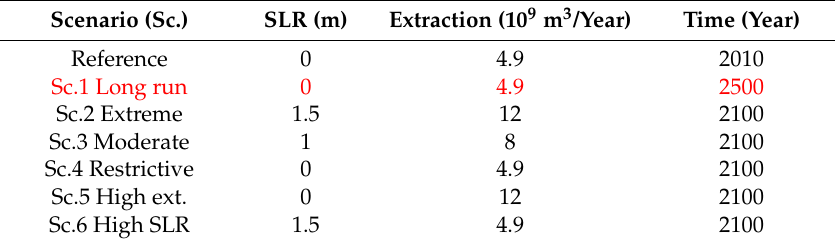
Table 1. Future scenarios for sea-level rise (SLR) and groundwater